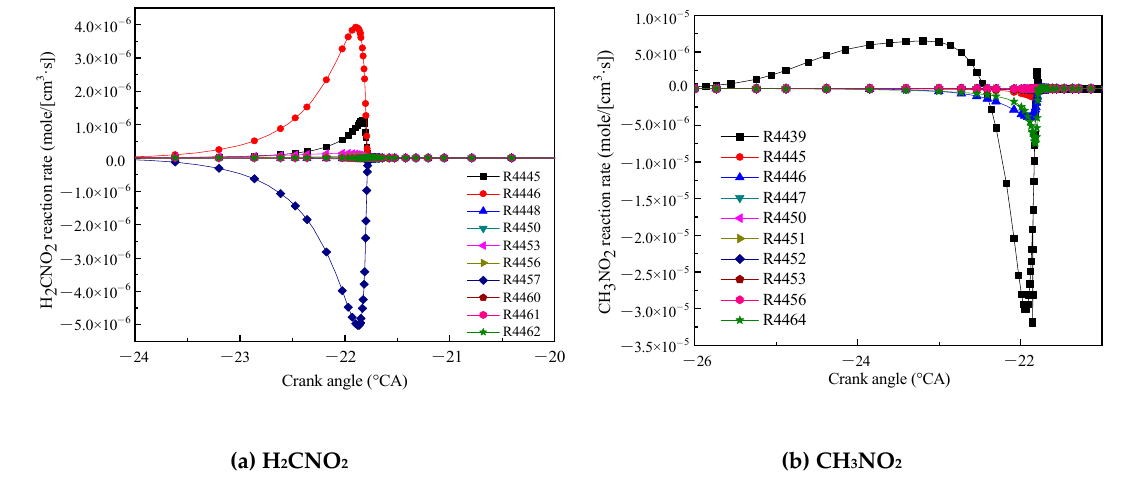
Figure 9. Main reaction rate of H 2 CNO 2 ( a ) and CH 3 NO 2 ( b ).